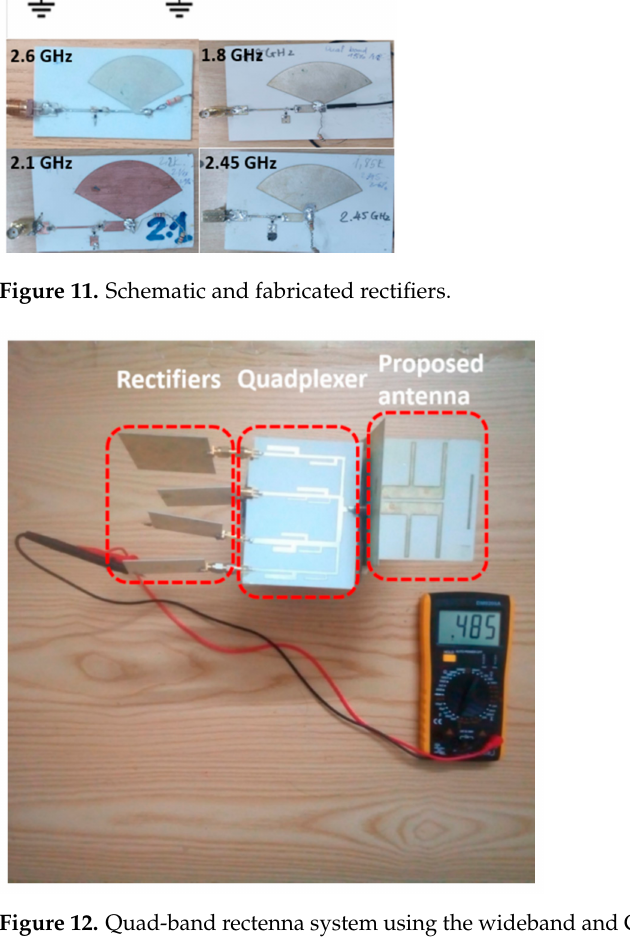
Figure 12. Quad-band rectenna system using the wideband and CP antenna with a maximum output voltage at 2.6